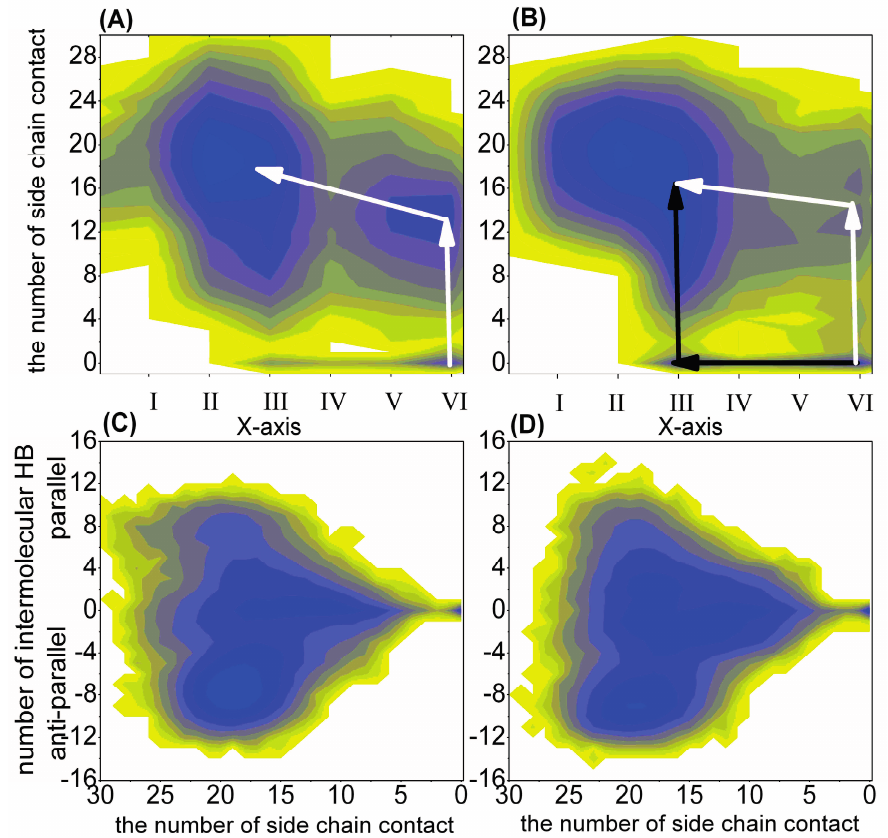
Figure 2. The free energy surface (in kJ/mol) of the ( α -syn12) 2 dimer projected on other representative reaction coordinates. ( A ) is the free energy surface based on the X -axis and the number of side chain contact at physiological pH; ( B ) is the free energy surface based on the X -axis and the number of side chain contact at acidic pH; ( C ) is the free energy surface based on the number of side chain contact and the number of intermolecular hydrogen bond at physiological pH; and ( D ) is the free energy surface based on the number of side chain contact and the number of intermolecular hydrogen bond at acidic pH The X -axis represents the existence of the following: (VI), NUMintraHB > 0, Lhelix > 0, Lsheet = 0; (V), NUMintraHB > 0, Lhelix > 0, Lsheet > 0; (IV), NUMintraHB > 0, Lhelix = 0, Lsheet = 0; (III), NUMintraHB > 0, Lhelix = 0, Lsheet > 0; (II), NUMintraHB = 0, Lhelix = 0, Lsheet > 0; and (I), NUMintraHB = 0, Lhelix = 0, Lsheet =